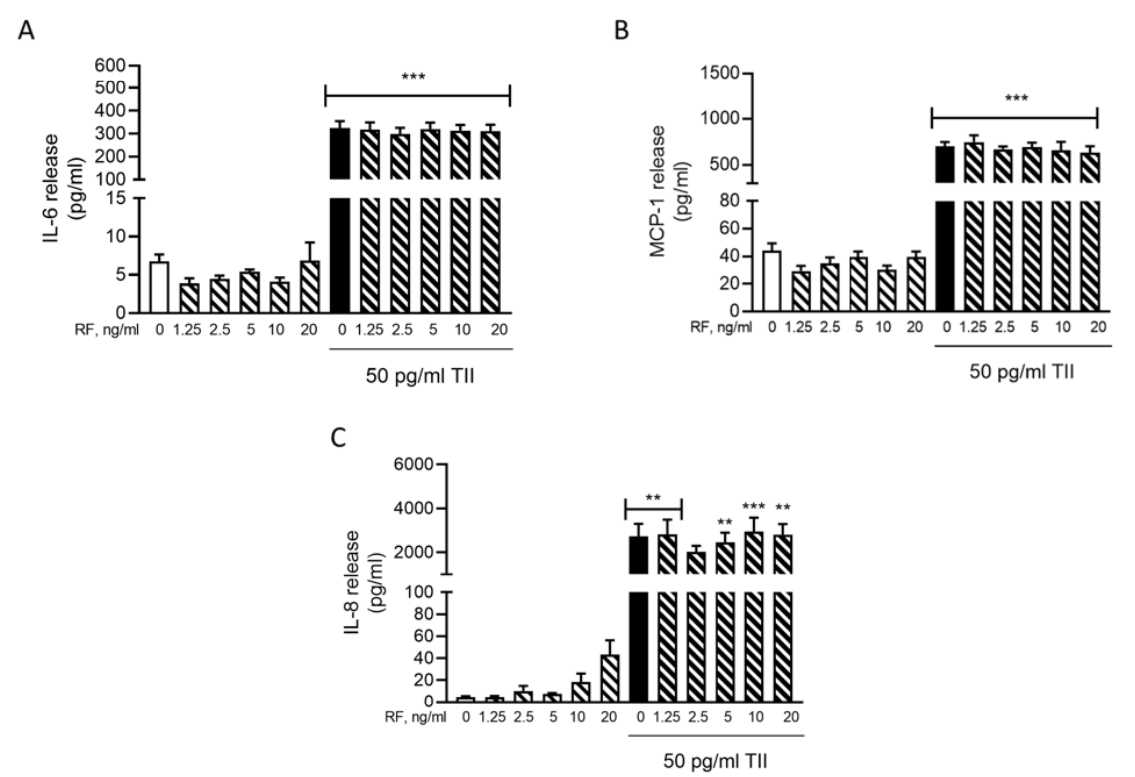
Figure 4: Effects of remifentanil on IL-6, MCP-1 and IL-8 release. C20 cells were treated with rem- ifentanil (RF) at different concentrations alone or in combination with 50 pg/ml TII for 6 h. ( A ) The incu- bation medium was used to evaluate the release of IL-6 with a specific ELISA. Results are pooled anal- ysis of three independent experiments. Data are means ± SEM (n=7-10) and were analyzed by one- way ANOVA followed by the Bonferroni's post hoc test. ***, P<0.001, versus Control. ( B ) The incubation medium was used to evaluate the release of MCP-1 with a specific ELISA. Results are pooled analysis of three independent experiments. Data are means ± SEM (n=11-12) were analyzed by one-way ANOVA followed by the Bonferroni's post hoc test. ***, P<0.001, versus Control. ( C ) The incubation medium was used to evaluate the release of IL-8 with a specific ELISA. Results are pooled analysis of three independent experiments. Data are means ± SEM (n=8-16) and were analyzed by one-way ANOVA followed by the Bonferroni's post hoc test. **, p<0.01; ***, p<0.001, versus